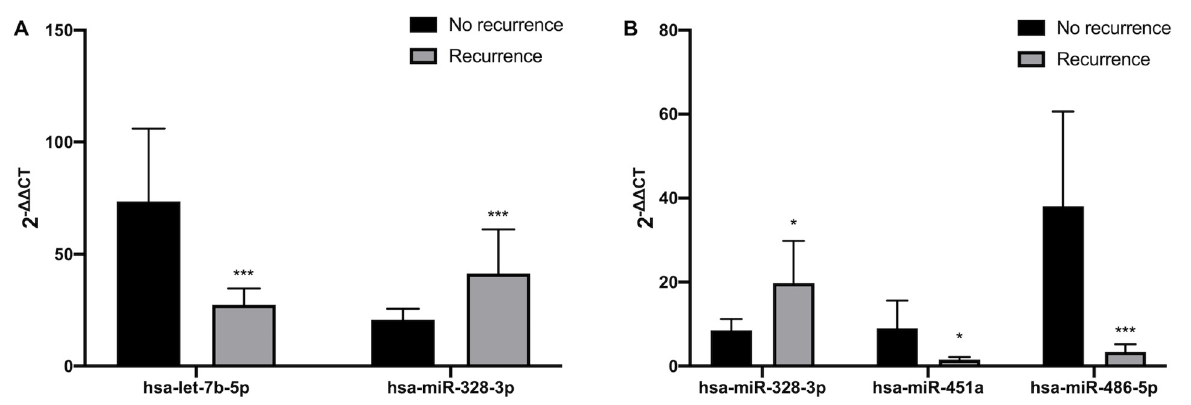
Figure 1. Differential expression of miRNAs in no-recurrence vs. recurrence AF patients ( A ) plasma from peripheral blood ( B ) plasma from left atrium blood. Data are presented as mean ± S.E.M. * p < 0.05, *** p < 0.001.